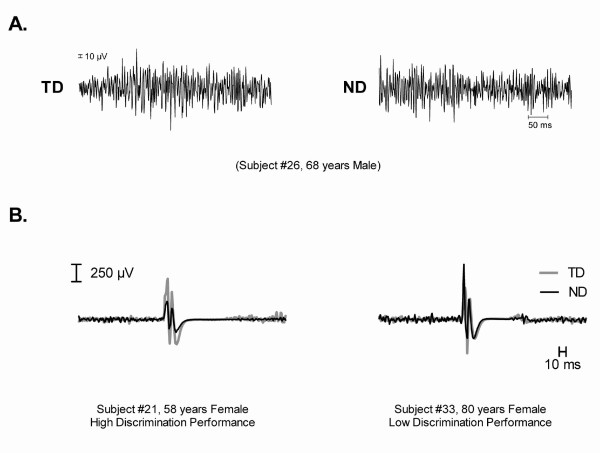
Electromyographic (EMG) activity and MEP traces. A. typical example of electromyographic (EMG) activity elicited in the FDI muscle during performance of the two finger movement tasks (discrimination, TD; non discrimination, ND). Note the similarity between the two tasks (TD vs. ND) in terms of EMG patterns produced. B. Examples of task-specific facilitation recorded in the FDI in two individuals, one having high (100%) and another having low (56%) discrimination performance. Note the task-related increase in MEP amplitude in the TD condition in the younger senior with high discrimination performance, and the similarity in MEP amplitudes between the TD and ND conditions in the older senior with low discrimination performance.